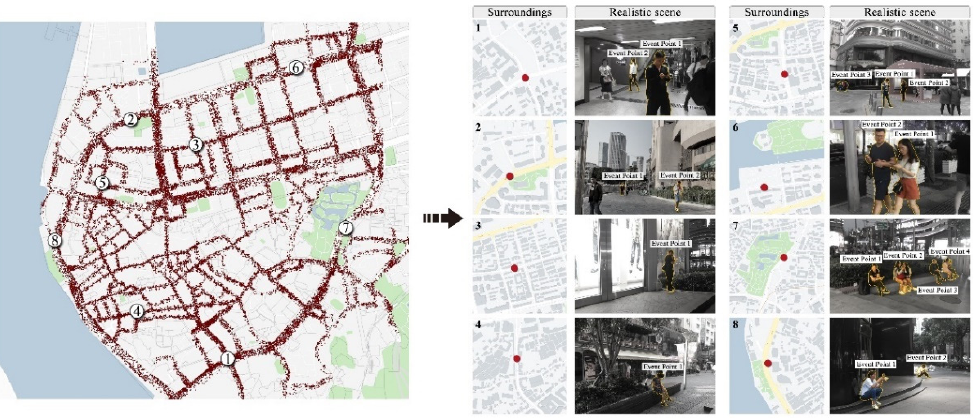
Figure 3. People using mobile phones in the street and generating LBS records.